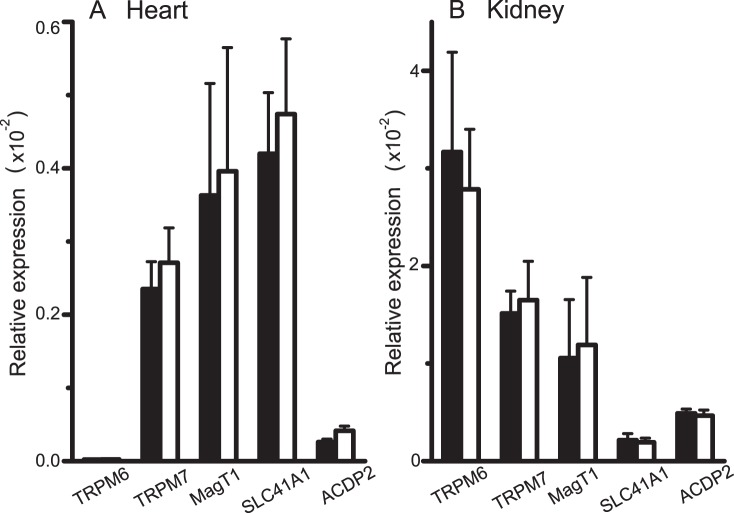
Expression of Mg2+ channels/transporters.Quantities of mRNA transcripts for TRPM6, TRPM7, MagT1, SLC41A1 and ACDP2 relative to that of GAPDH in ventricular tissue (A) and kidney tissue (B). Columns represent mean±SEMs of the data obtained from 6–7 rats (except for ACDP2, n = 3–4) fed the control diet (filled columns) and the Mg-deficient diet (open columns) for 4 weeks.